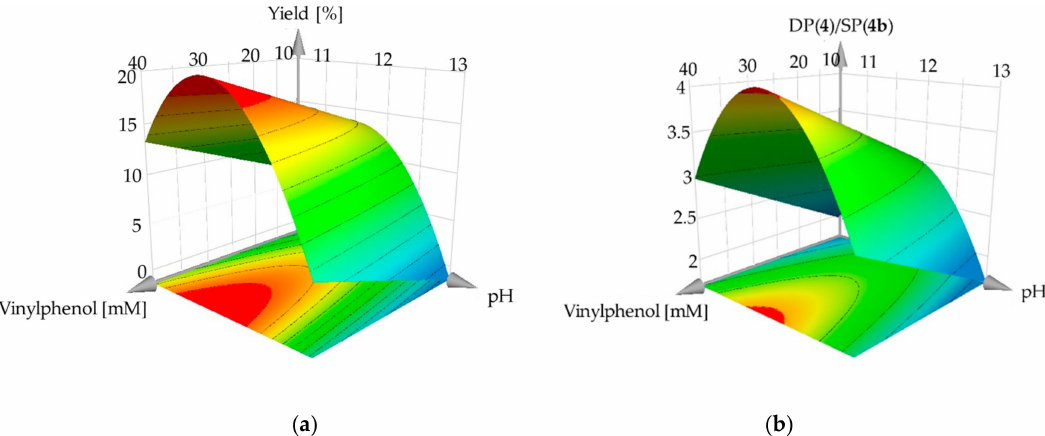
Figure 1. Surface plots of the Design of Experiments (DoE) analysis; ( a ) yield (y-axis), vinyl phenol concentration (z-axis), pH-value (x-axis); ( b ) desired product to side product ratio (DP / SP) (y-axis), vinylphenol 2 concentration (z-axis), pH-value